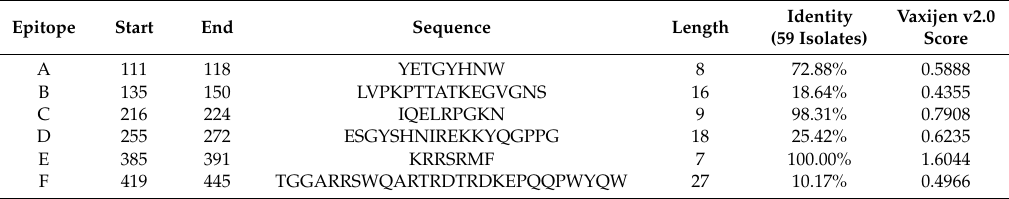
Table 3. Linear B cell epitopes prediction of PPV7 Cap using BepiPred 2.0.